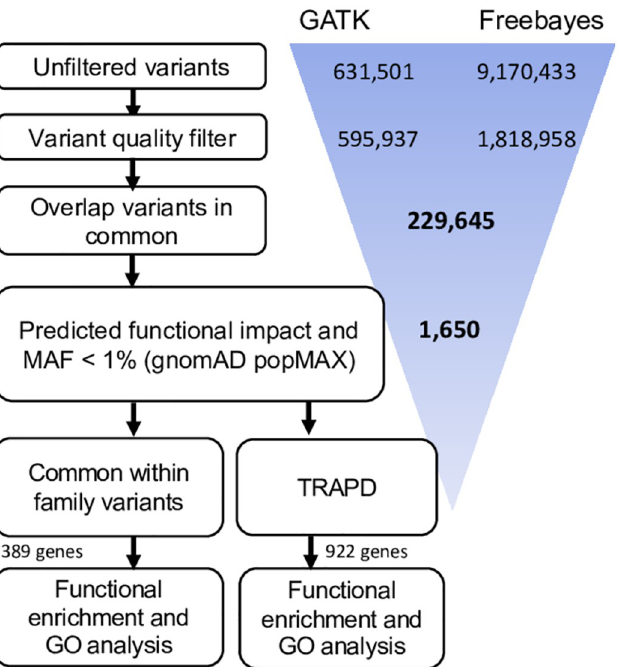
Fig 1. Analysis overview. Variants were called using GATK and FreeBayes, then filtered using a hard filter. High confidence variants were selected based on those that were detected by both variant callers. Variants were further filtered according to population allele frequency (retaining those < 1%) and predicted functional impact. Two distinct analyses were performed to identify potentially important genes, pathways, and ontology terms: 1) Identification of genes that have deleterious variants in multiple families; 2) A gene-based mutational burden analysis.